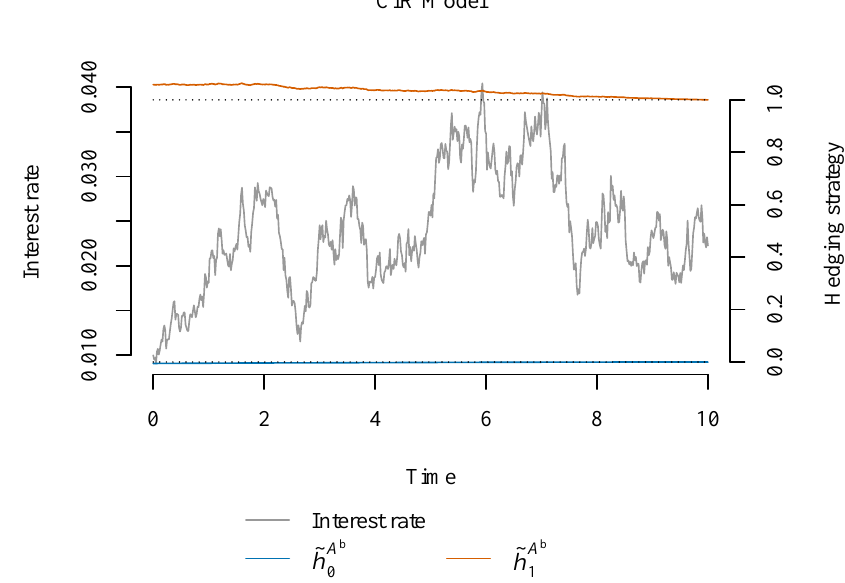
Figure 4. A simulated path for the CIR interest rate model (left axis) and the hedging strategy ˜ h A b ˜ h A b in the presence of taxes and expenses (right axis). In this (the CIR) case, there is a small investment 1 in the bank